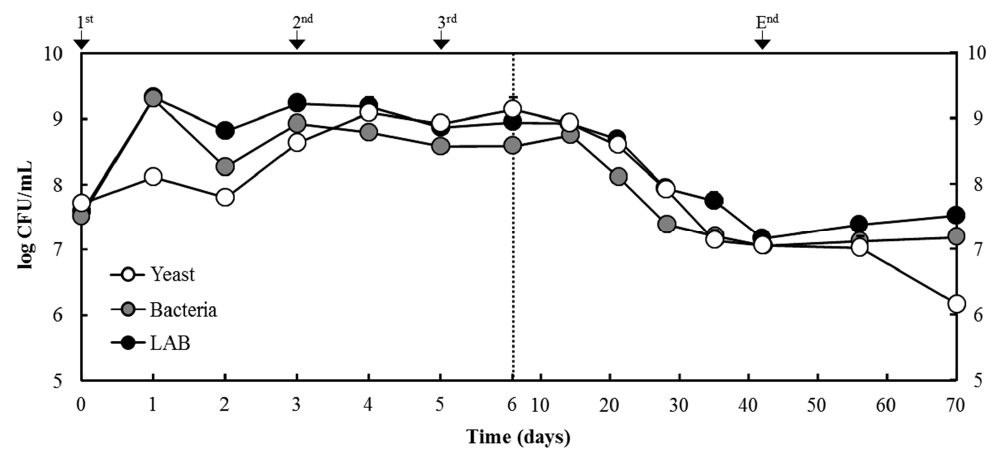
Figure 4. Changes in microbial counts (yeast, total bacteria, and lactic acid bacteria) during traditional Korean rice wine fermentation. By a culture-independent method, the species composition and the dynamics of the fungal and bacterial community during the different fermentation and storage times were investigated (Figure 5), and a wide diversity of bacterial species existed in all the pro- cesses. Of the 17 bands analyzed, the DNA sequences of ten bands corresponded to LAB, revealing that it was the major bacterial group in makgeolli fermentation. Mainly, Lacti- lactobacillus curvatus (band 3), Liquorilactobacillus satsumensis (band 4), and Pediococcus aci- dilactici (band 5) were found to be predominant during the entire process, including the storage period. The species appeared as inferior bands in nuruk at day 0 but as dominant bands after one day. On the other hand, Lactiplantibacillus plantarum (band 1) was detected after one day and remained as a band with weak intensity over the following days. P. pentosaceus (band 8) was consistently detected as one of the marginal species throughout the overall fermentation process. In addition, the bands corresponding to L. sakei (band 2), L. satsumensis (band 15), Lacticaseibacillus casei (band 16), and Lacticaseibacillus paracasei (band 17) also persisted throughout the fermentation process. As other bacteria genera, Erwinia sp. (band 6), Pantoea sp. (bands 7, 9, 10, 14), Enterobacter sp. (bands 11, 13), and P. inopinatus (band 12) were identified in the nuruk sample but disappeared as the fermenta- tion progressed.